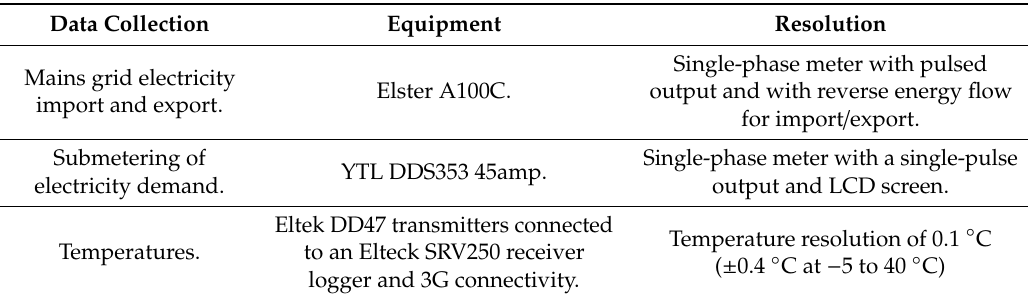
Table 4. Specification of monitoring